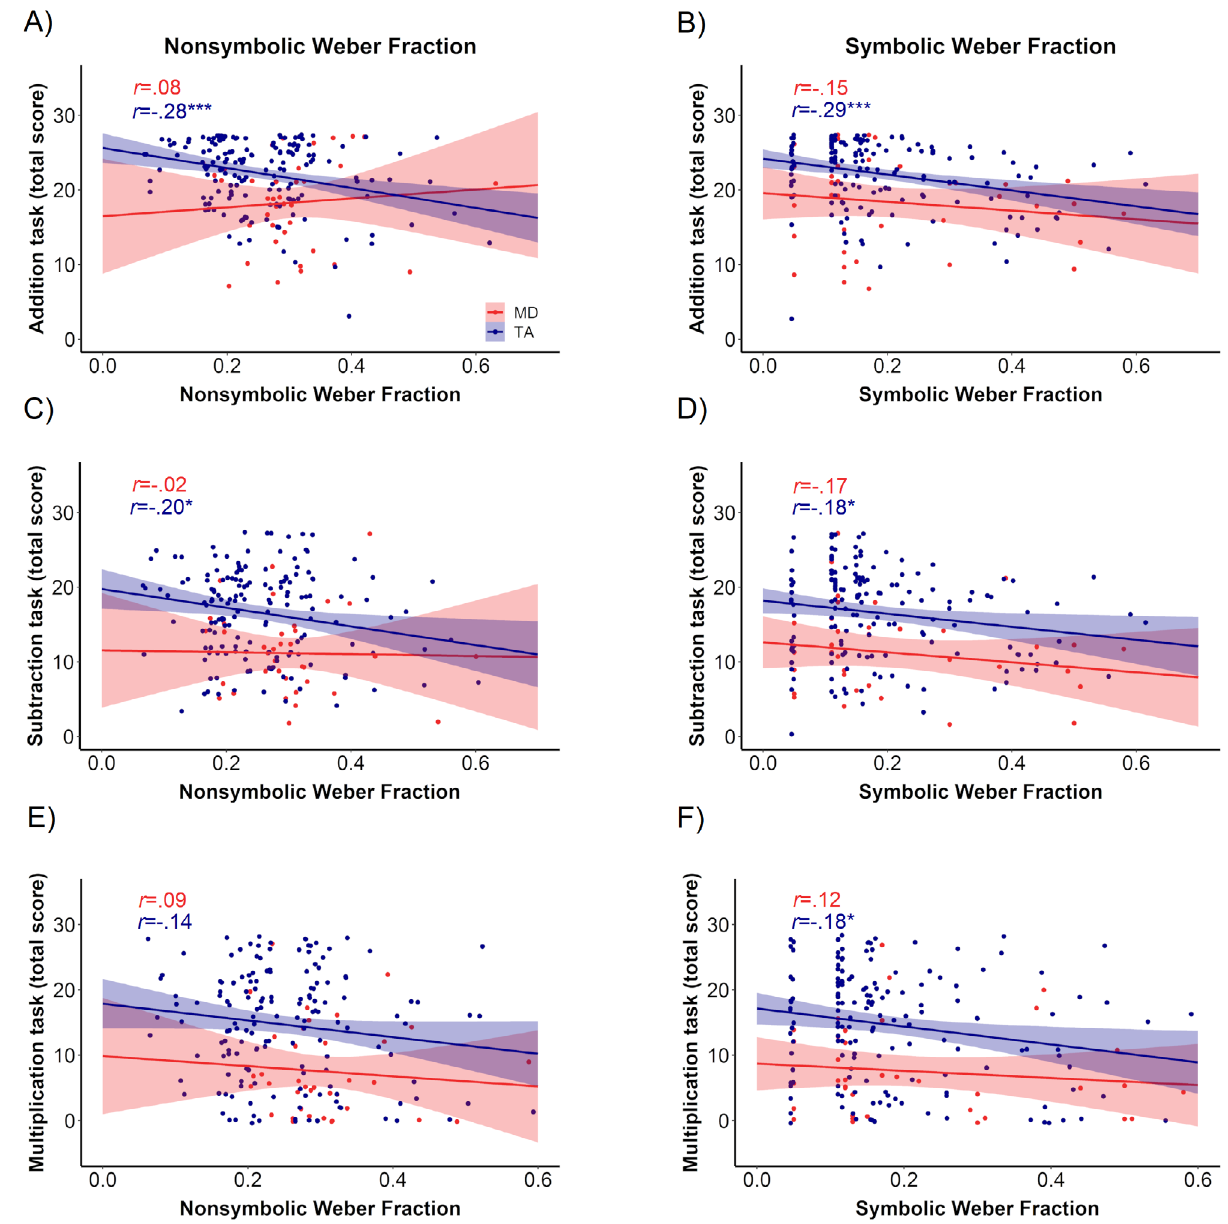
Figure 3. Association between numerical magnitude processing and arithmetics in children with typical achievement (TA, in blue) and mathematics difficulties (MD, in red). (A) correlation between nonsymbolic weber fraction and addition scores, (B) correlation between symbolic weber fraction and addition scores, (C) correlation between nonsymbolic weber fraction and subtraction scores, (D) correlation between symbolic weber fraction and subtraction scores, (E) correlation between nonsymbolic weber fraction and multiplication scores, and (F) correlation between symbolic weber fraction and multiplication